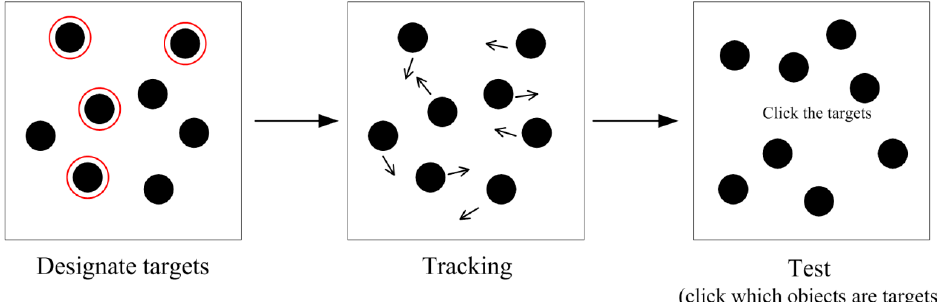
Figure 1. In the multiple object tracking (MOT) task, the targets to be tracked are first designated, for example, by drawing a red circle around the targets. After the target designation, the target and distracter items (all identical to each other) move for a few seconds. For the test phase, all objects stop moving and the participant is asked to click on the targets.